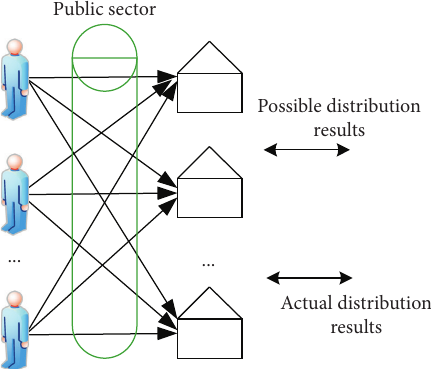
Figure 4: The allocation of public